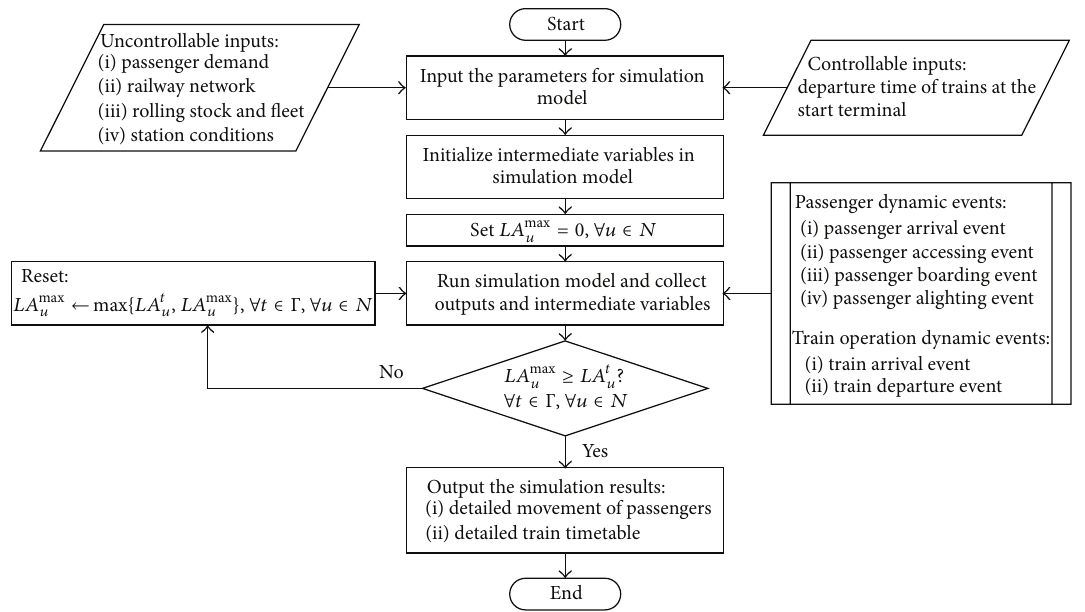
Figure 2: Framework of simulation model.